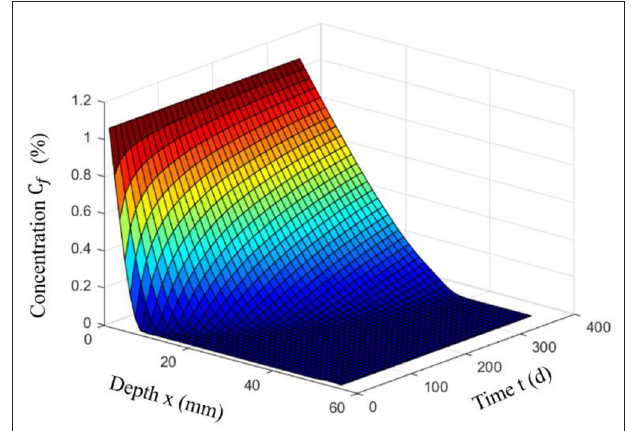
FIGURE 6 | Concentration distribution of free chloride ions under time and depth.